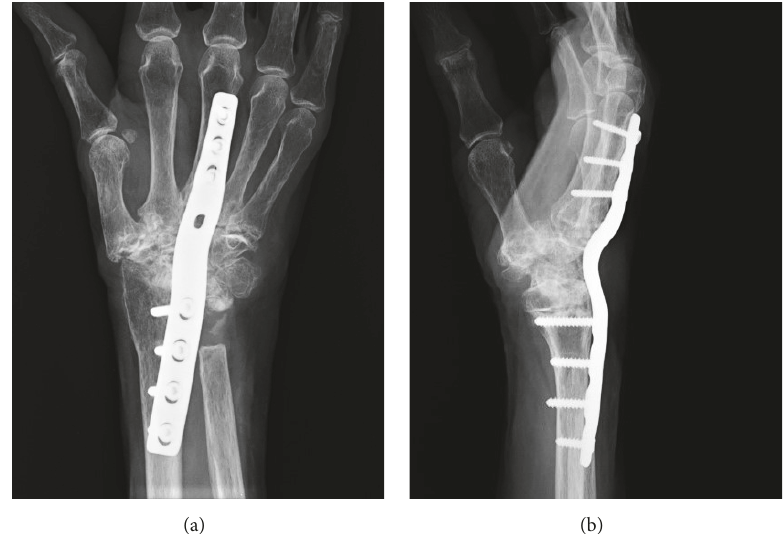
Figure 2: Representative anteroposterior (a) and lateral (b) radiographs of wrist arthrodesis using the AO wrist fusion